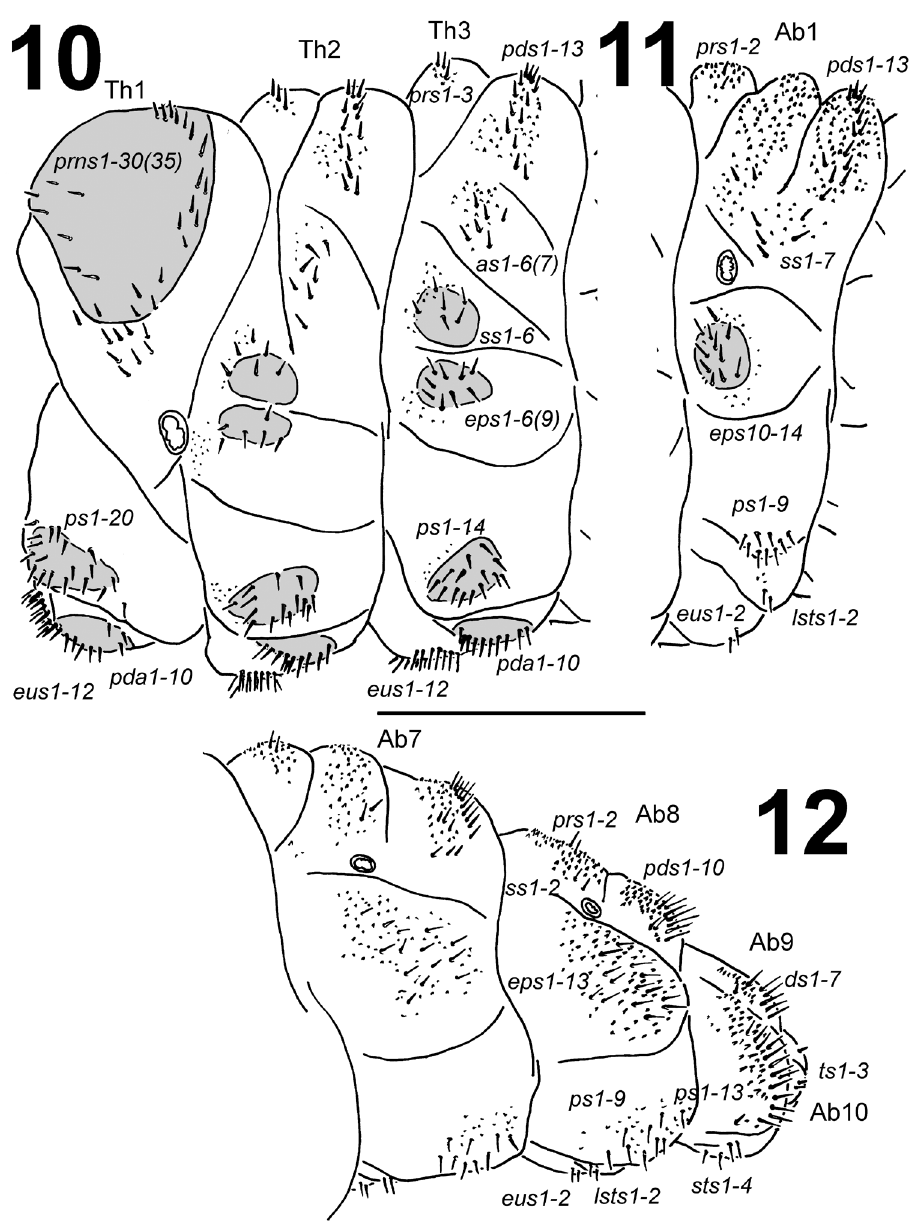
view of abdominal segment I 12 Lateral view of abdominal segments VII-X. Abbreviations: prns – pro- notal s., prs – prodorsal s., pds – postdorsal s., as – alar s., ss – spiracular s., eps – epipleural s., ps – pleural s., pda – pedal s., lsts – laterosternal s., eus – eusternal s., ds – dorsal s., sts – sternal s., Th1-3 – number of thoracic segments, Ab1-10 – number of abdominal seg. Scale bar 2